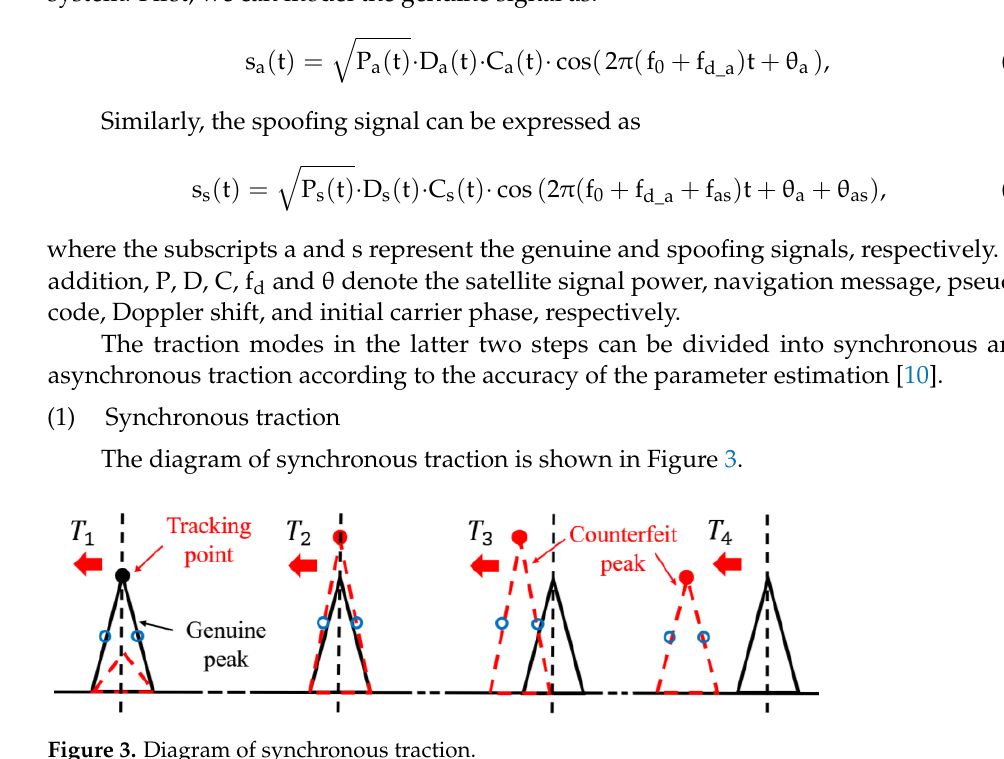
Figure 2. Demonstration of correlation peak distortion of conventional traction strategy.